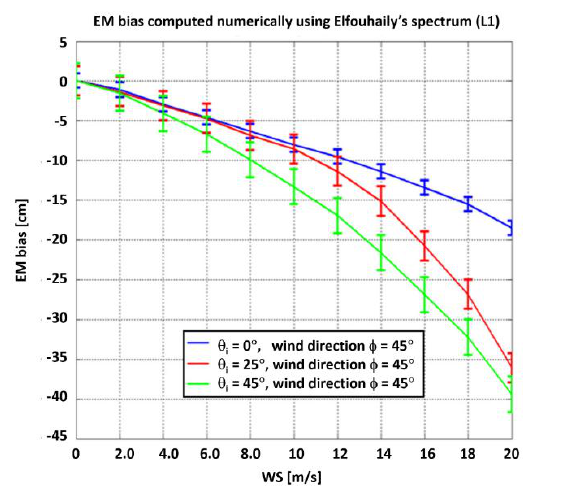
Figure 4. Estimated EM bias for θ i